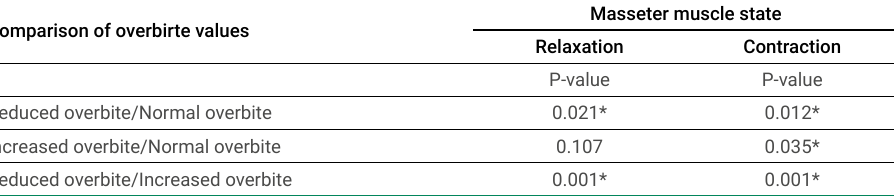
Table 5. Comparison of masseter muscle thickness in different occlusal vertical dimensions using Tukey’s multiple comparison analysis Comparison of overbirte